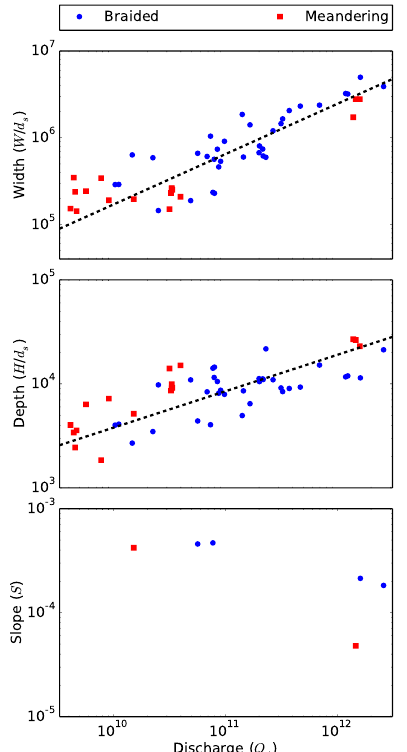
Figure 7. Width, depth and slope as functions of the water dis- charge. The solid green line corresponds to the threshold theory. The solid grey line is fitted to the data